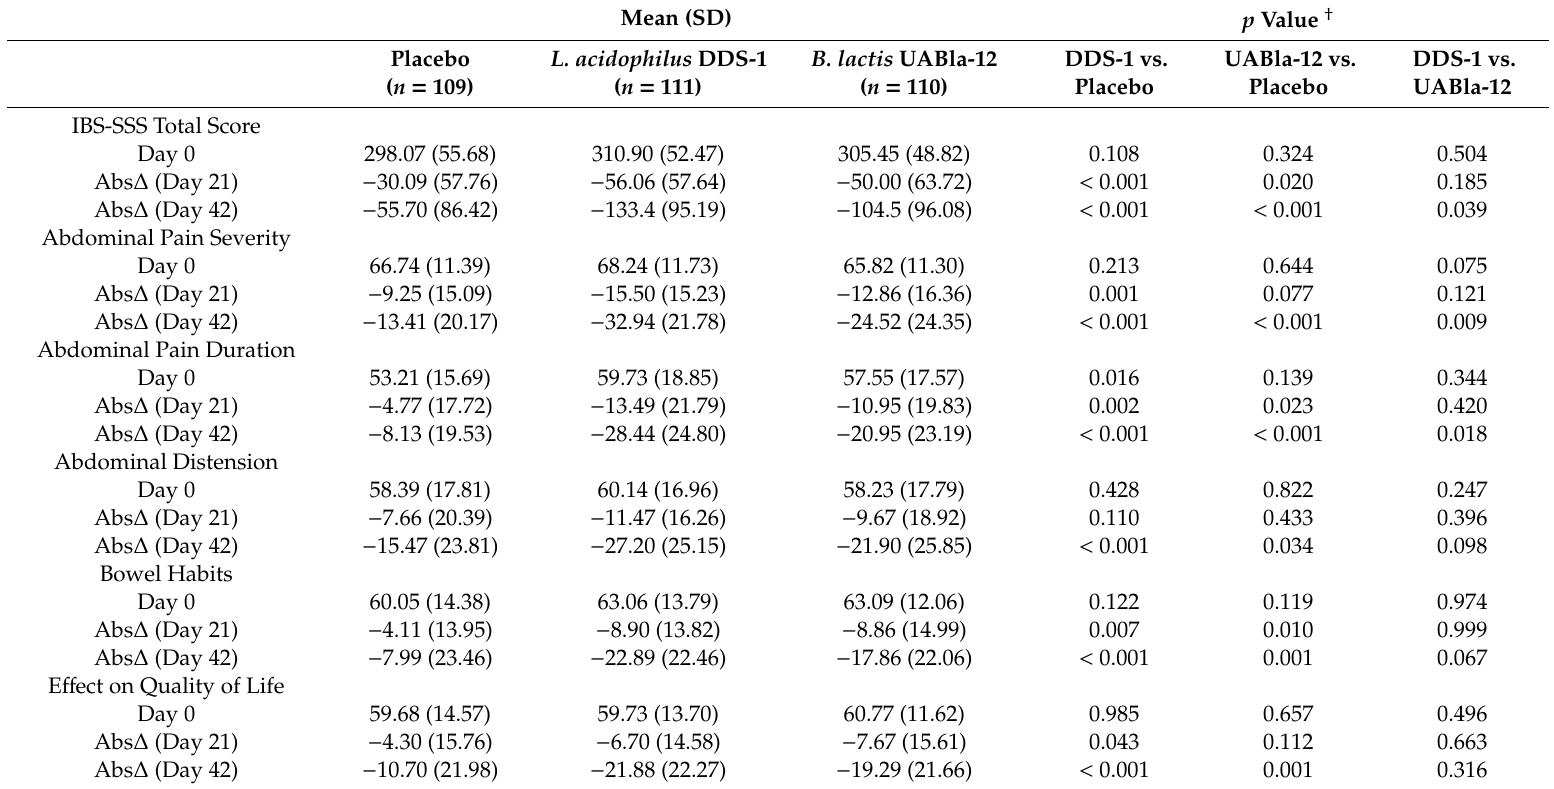
Table 3. IBS symptom severity total and domain specific scores over the intervention